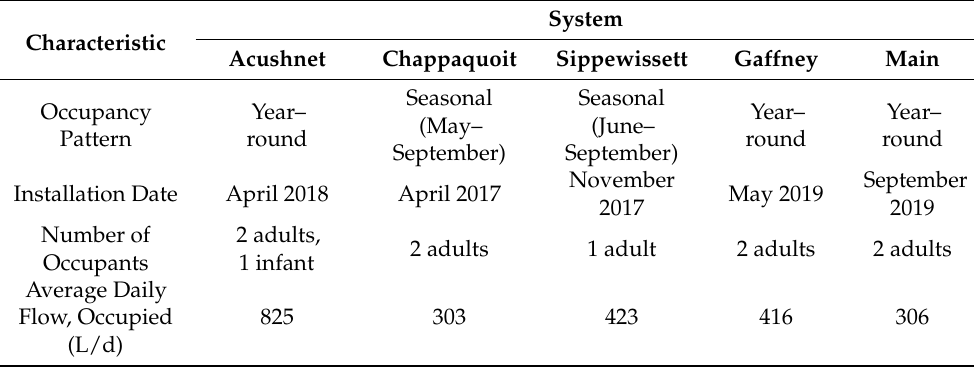
Table 1. System and site characteristics for systems installed in five private homes in southeastern Massachusetts (USA) in the towns of Acushnet (Acushnet), North Dartmouth (Gaffney), Westport (Main), and Falmouth (Chappaquoit and Sippewissett). Characteristic